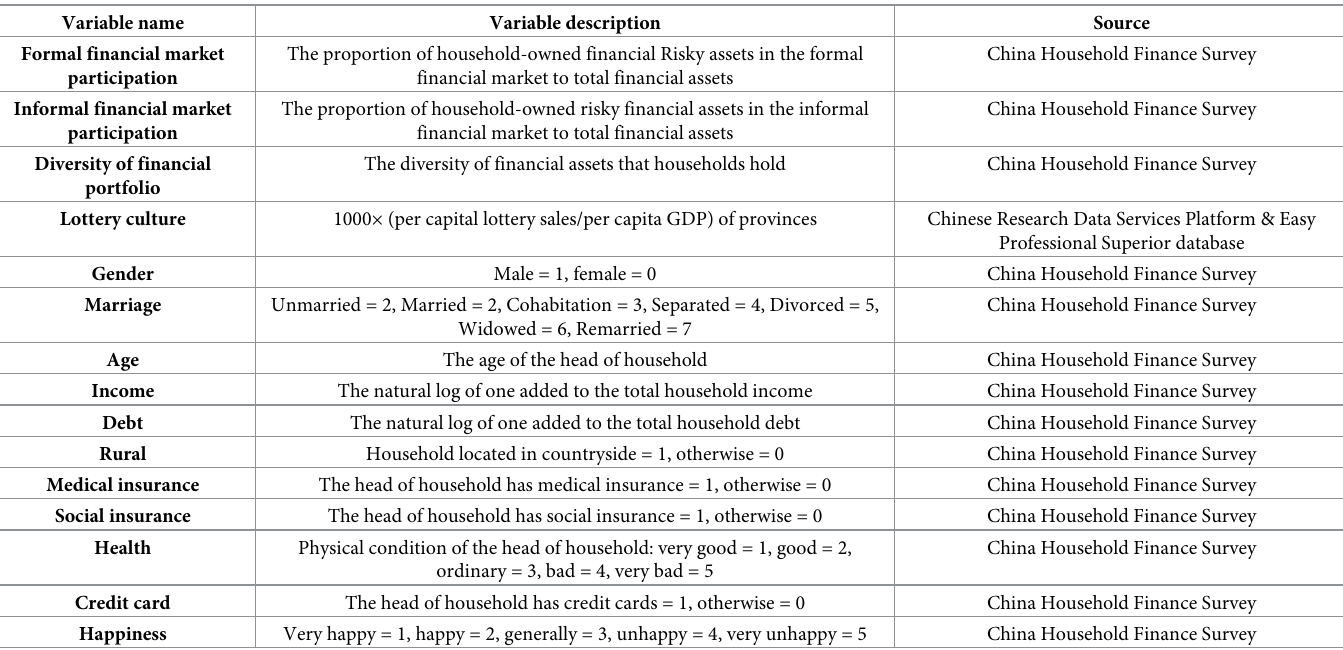
Table 1. Variable names, descriptions, and sources.